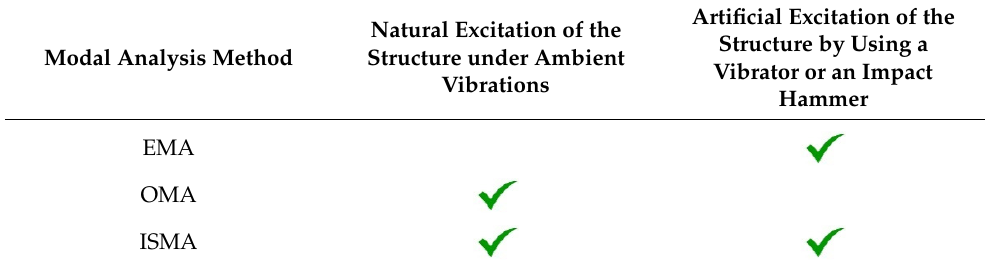
Table 1. Comparison of the famous modal analysis methods.